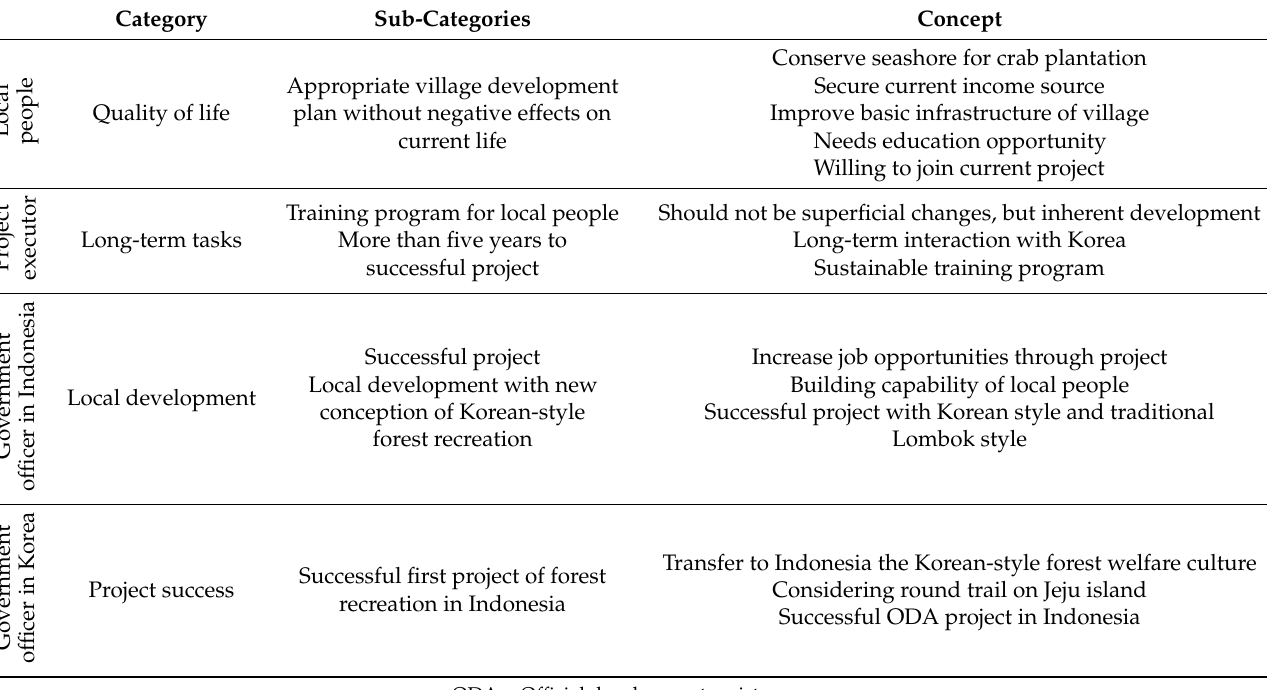
Figure 3. Interviews with government officer, project executor, and local community in 2014. Table 3. Summary of Interview Results in